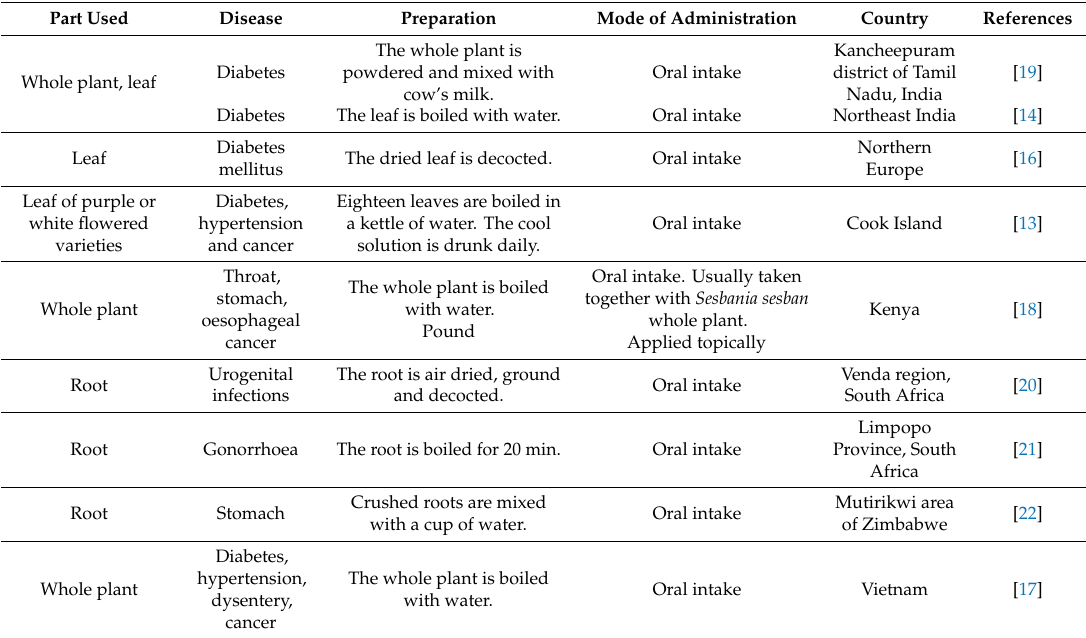
Table 1. Traditional use of C. roseus in some countries.